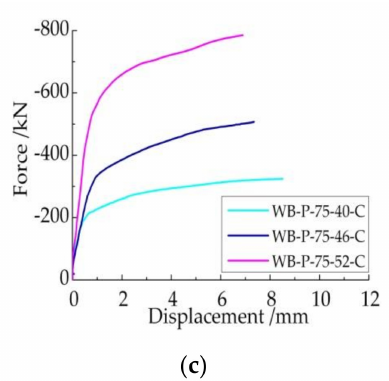
Figure 7. Relation curves between axial force and displacement measured in a monotonic compressive test, representing specimens in groups ( a ) TC, ( b ) WA and ( c ) WB.